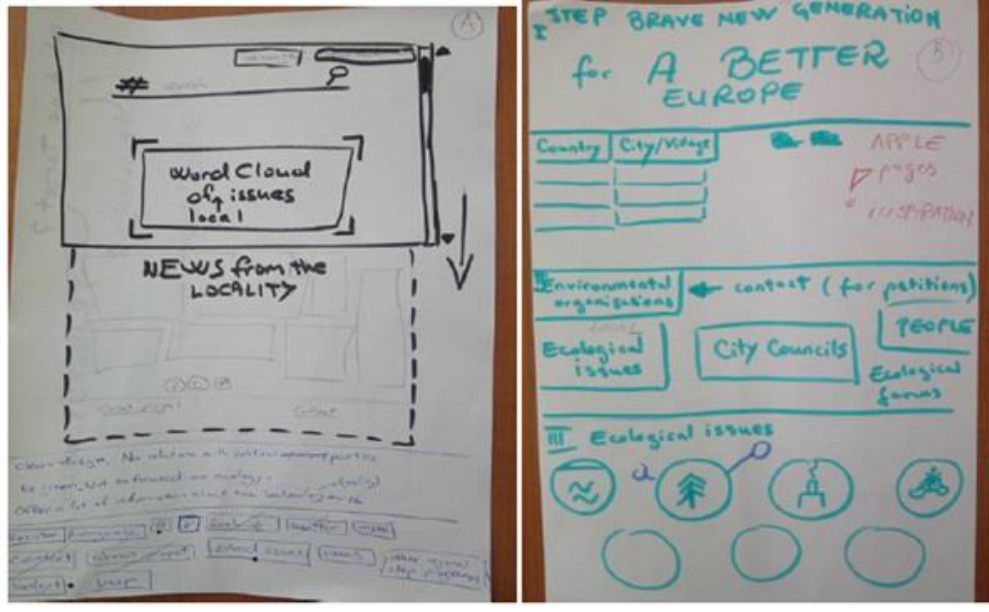
Fig. 4. Co-created landing pages ideas (Czech Republic)